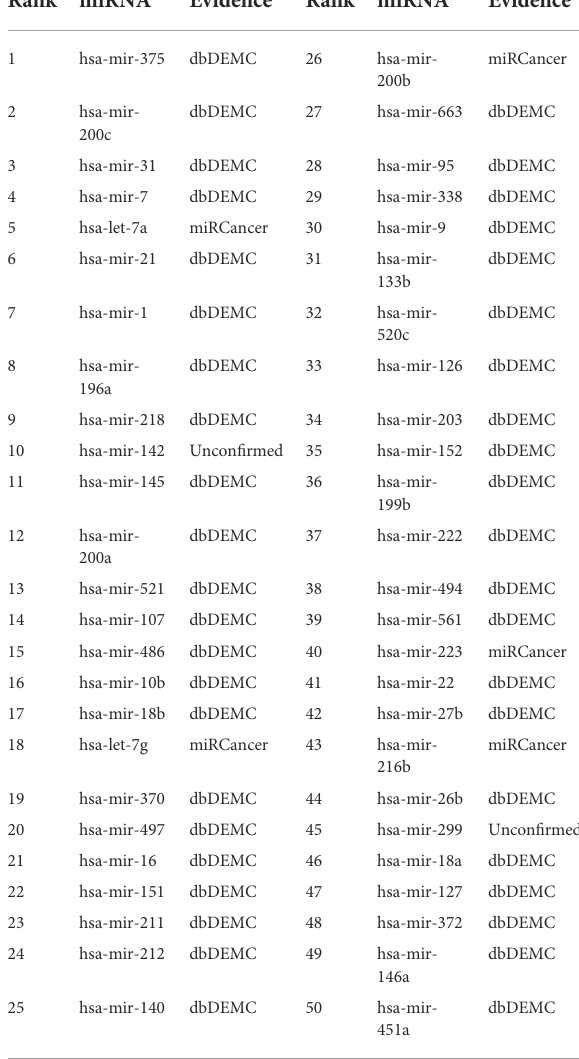
TABLE 5 Top 50 miRNAs related to esophageal neoplasms predicted by MKFGCNII. Rank miRNA Evidence Rank